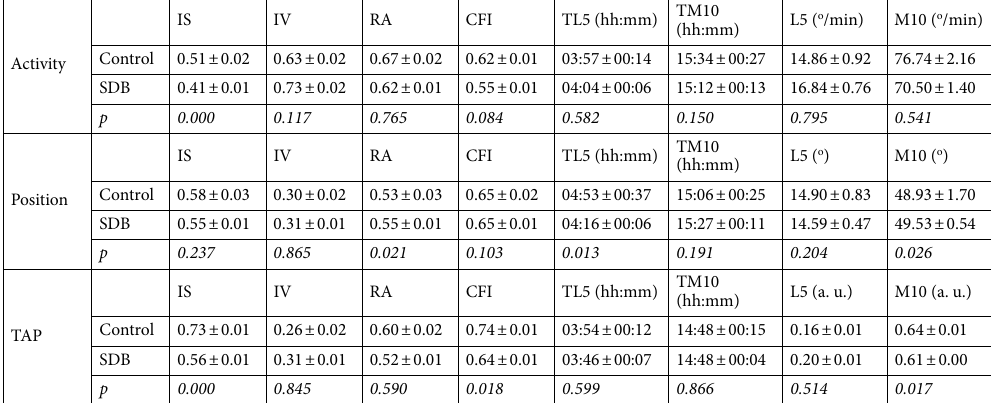
Table 1. Non-parametrical analysis of the circadian rhythms for activity, position and TAP in healthy subjects (n: 32) and SDB patients (n: 78). Interdaily stability (IS); intradaily variability (IV); relative amplitude (RA); circadian function index (CFI); mean of the 10 consecutive hours with the highest values (M10) and its timing (TM10); mean of the 5 consecutive hours with the lowest values (L5) and its timing (TL5). Values are expressed as the mean ± SEM. Significant differences between healthy and SDB subjects are highlighted in bold (p < 0.05, General Linear Model controlled for gender, age and BMI).